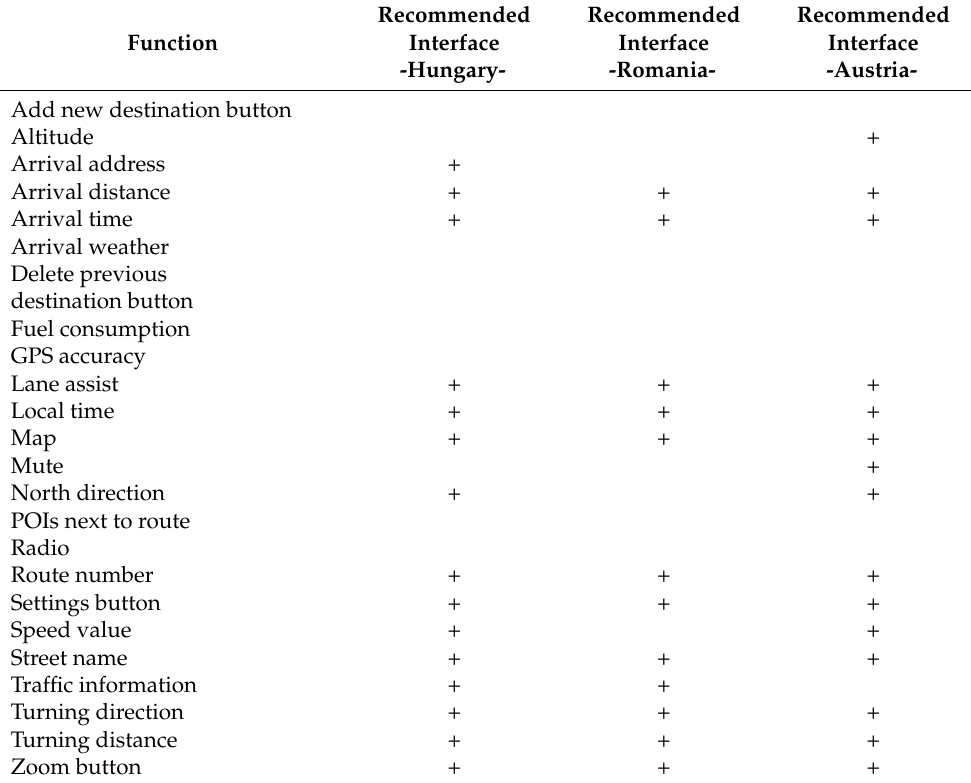
Table 4. Optional features and the needs by